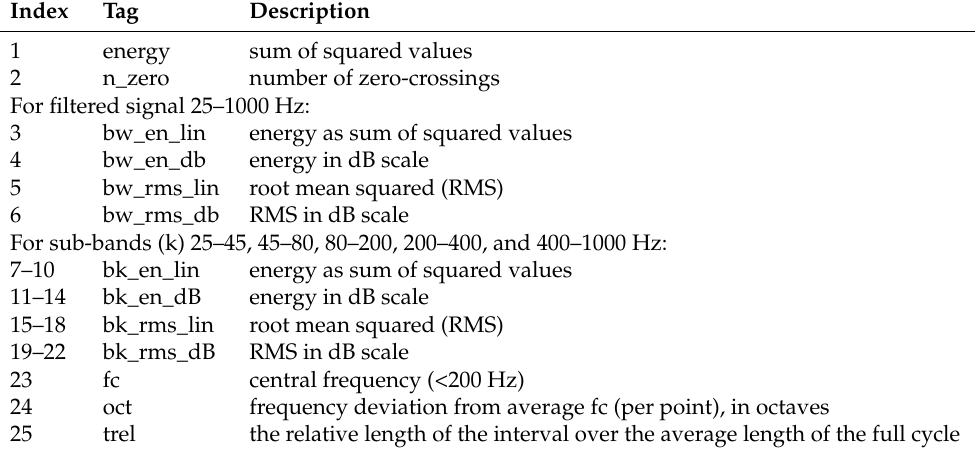
Table 2. Features extracted from all four intervals of the heartbeat cycle.